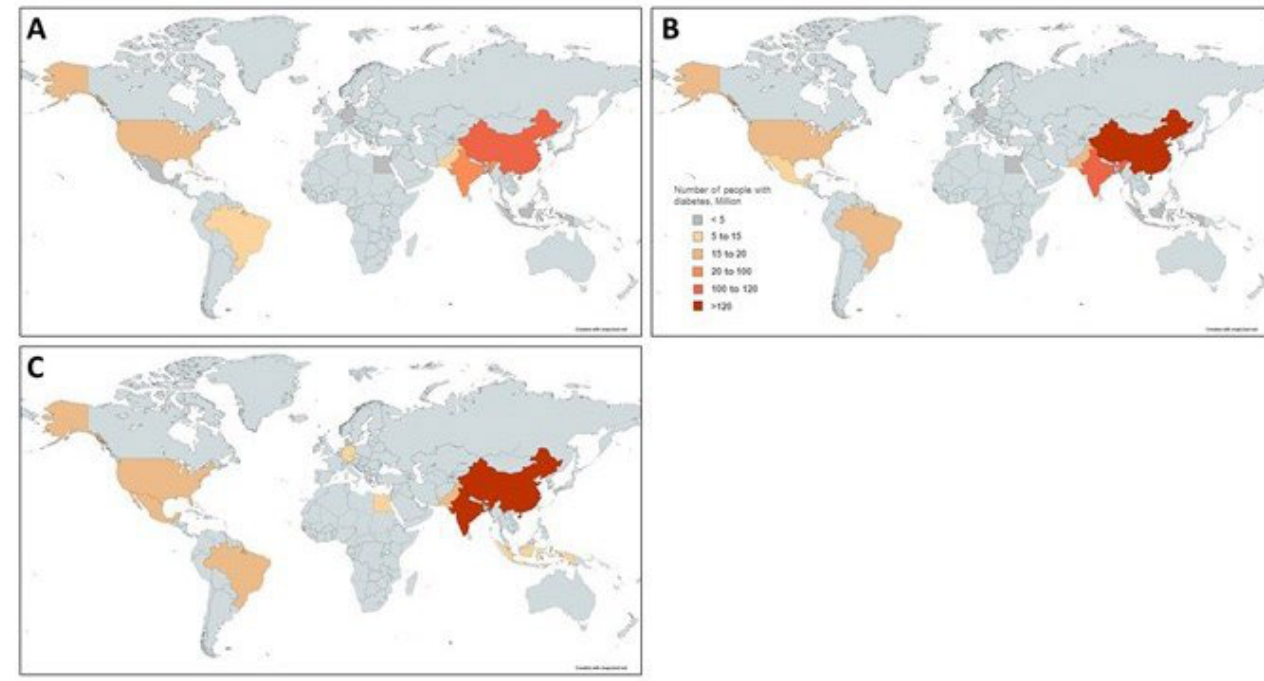
Figure 1. Estimated number of adults with diabetes (20–79 years) in the top 10 countries worldwide in ( A ) 2019, ( B ) 2030 and ( C ) 2045. Data for this figure is obtained from Mathers et al. [ Error! Book- mark not defined. ].